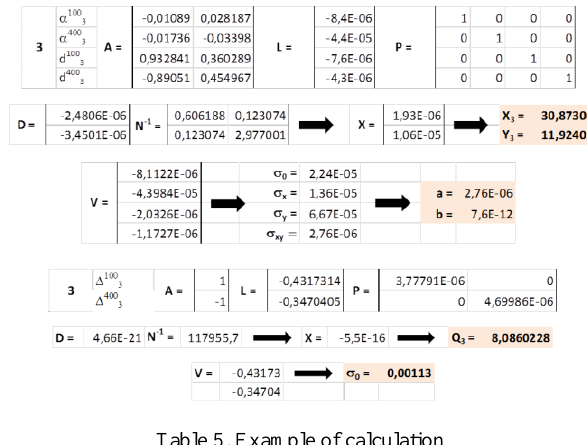
Table 5. Example of calculation